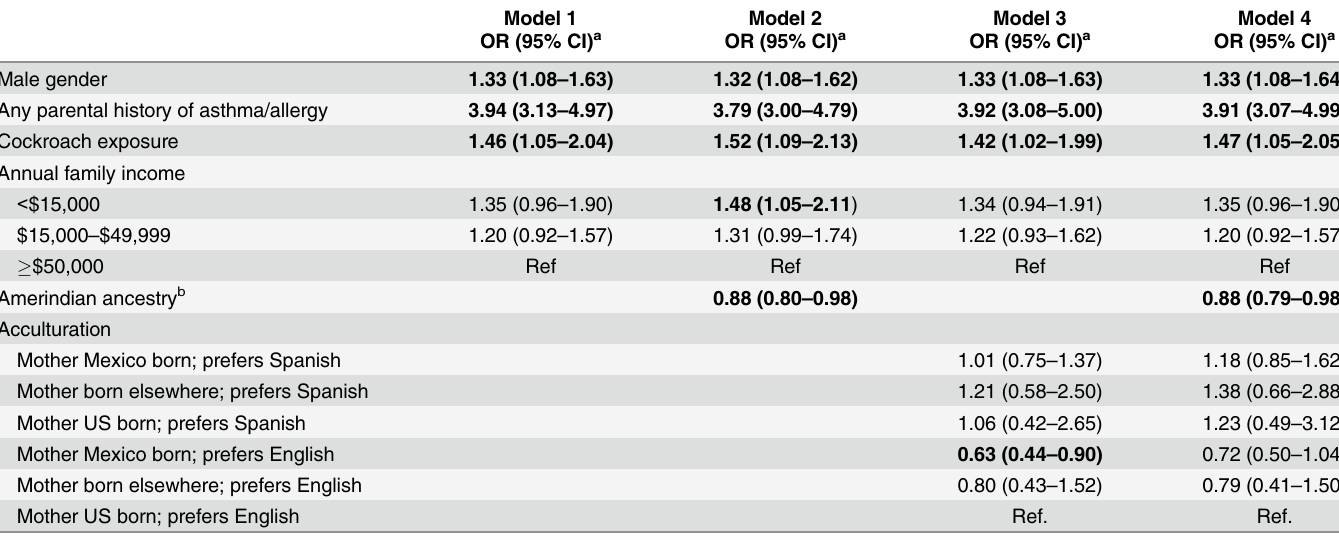
Table 6. Multivariate Association between Amerindian Genetic Ancestry and